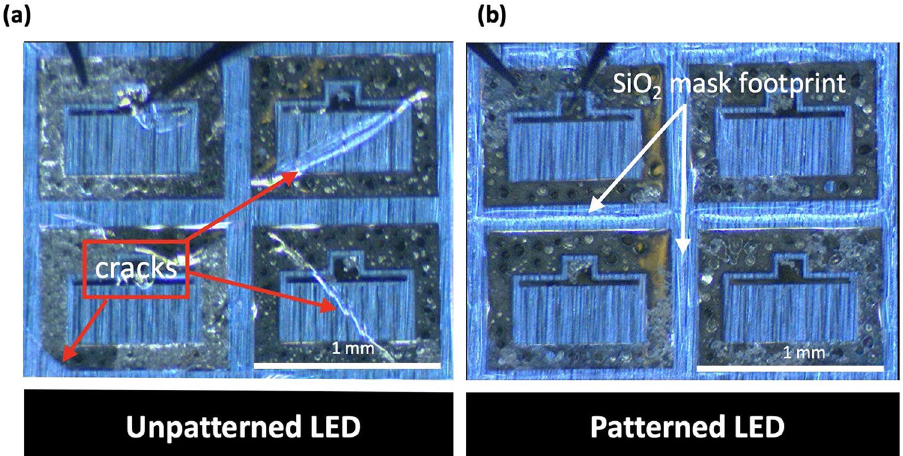
Figure 4. Optical microscope images of large area LEDs released and transferred to aluminum tape from ( a ) unpatterned and ( b ) patterned structures. Several cracks are observed for devices released from the unpatterned